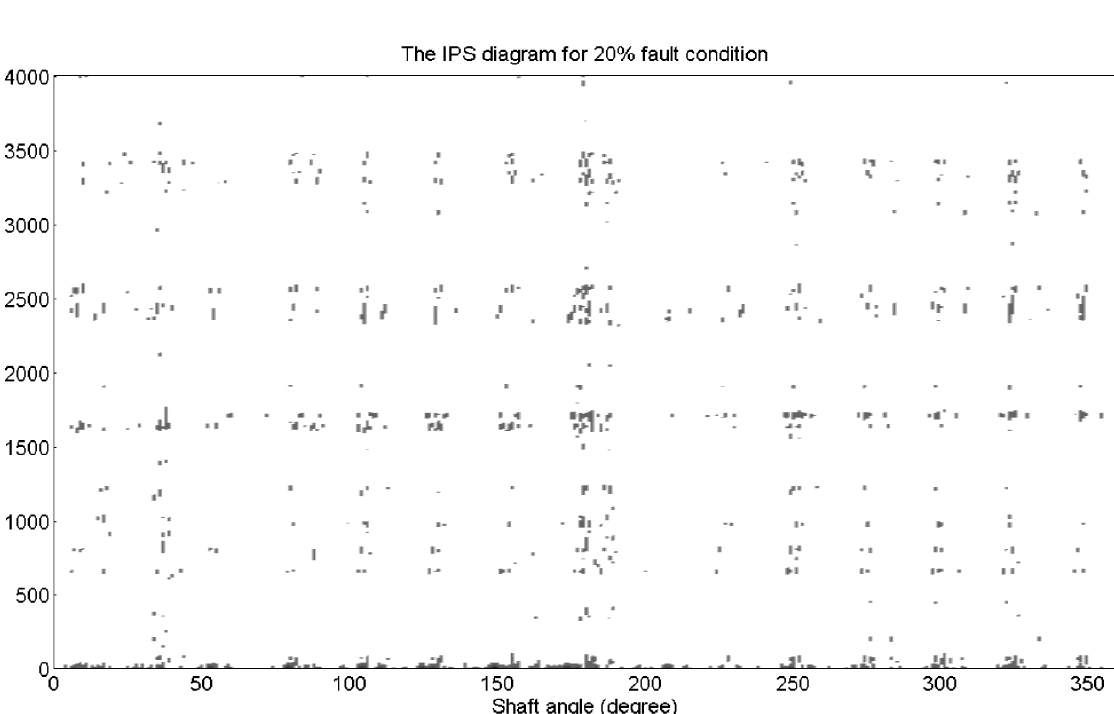
Fig. 7. IPS diagram for 5% fault condition.